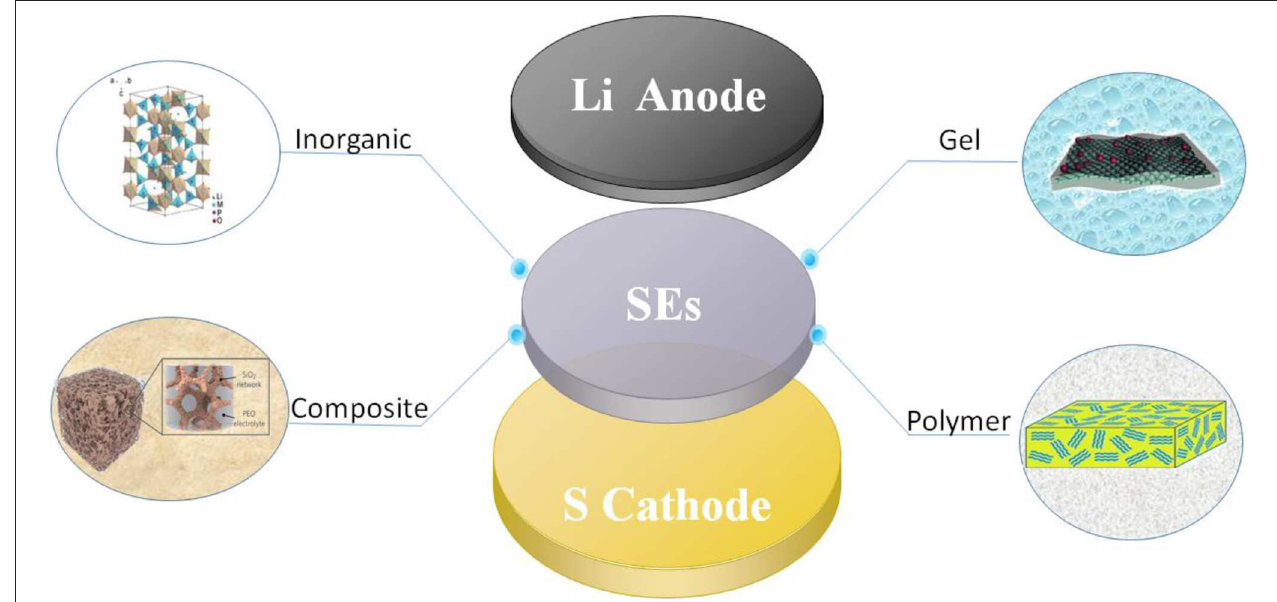
FIGURE 1 | Li-S battery diagram based on different electrolytes.